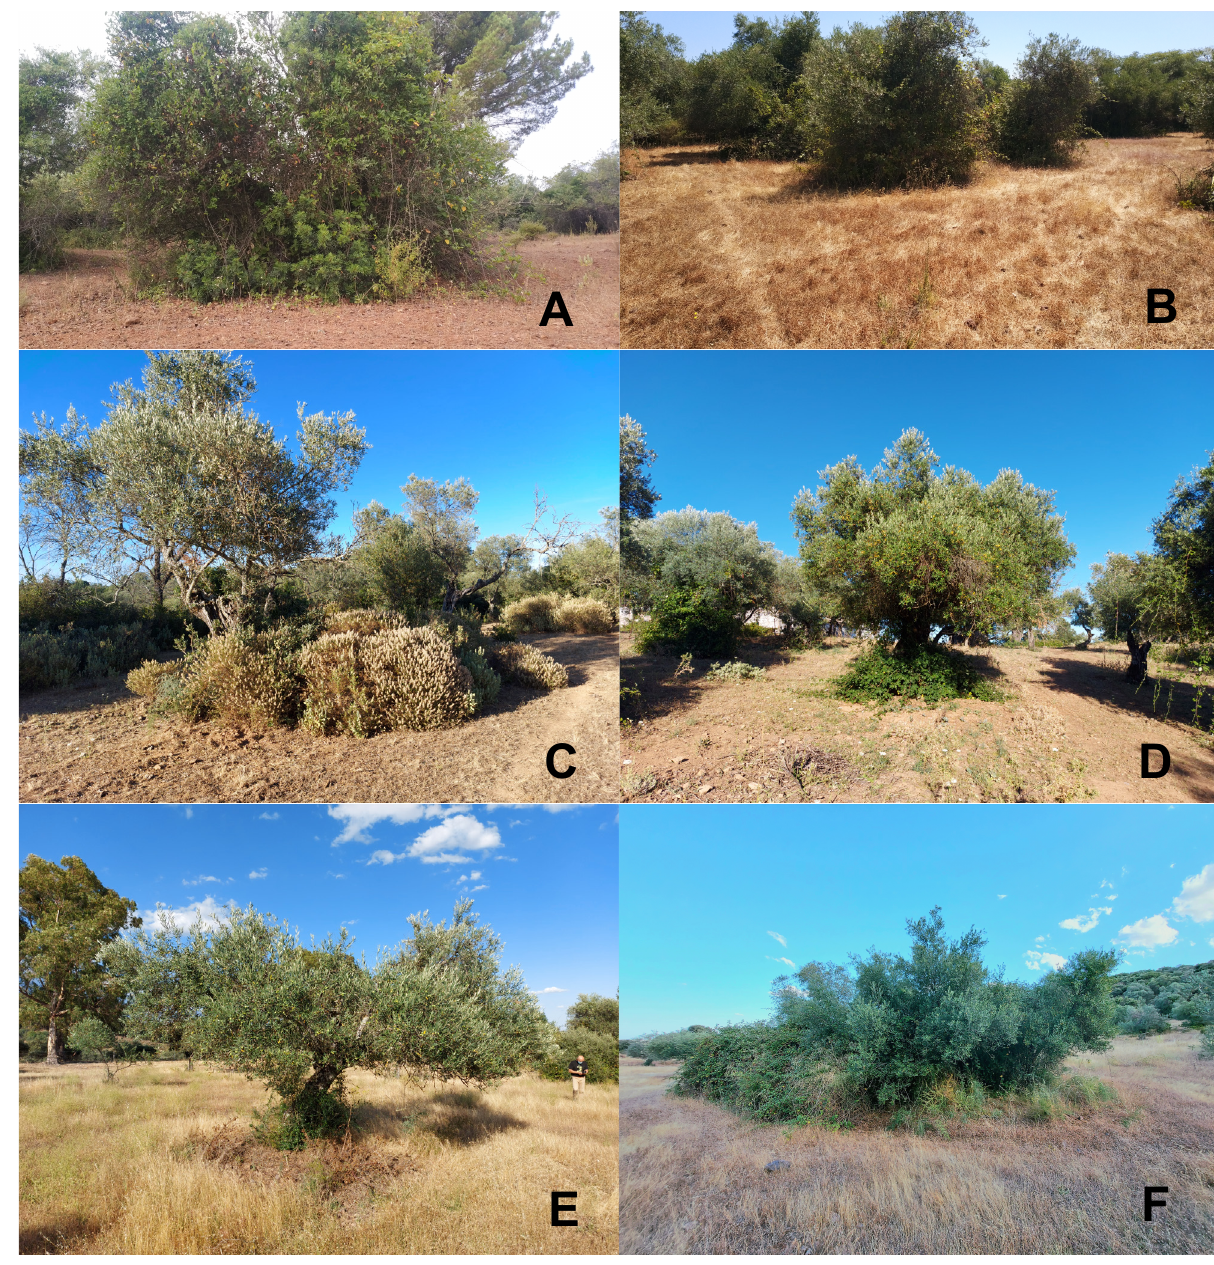
Figure 2. Vegetation patches surrounding olive trees at semiabandoned groves in Sierra Morena de Córdoba, Southern Spain (July 2021). A-B, La Soledad; C-D, Las Niñas; E-F,